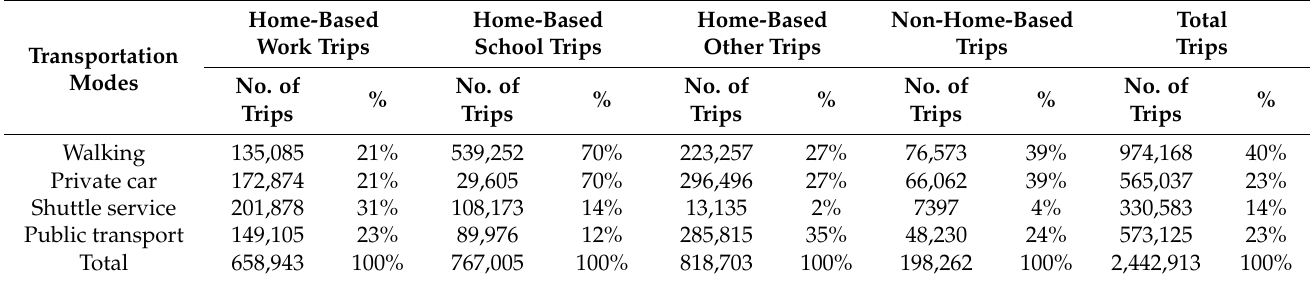
Table 1. Modal share and trip purposed distribution